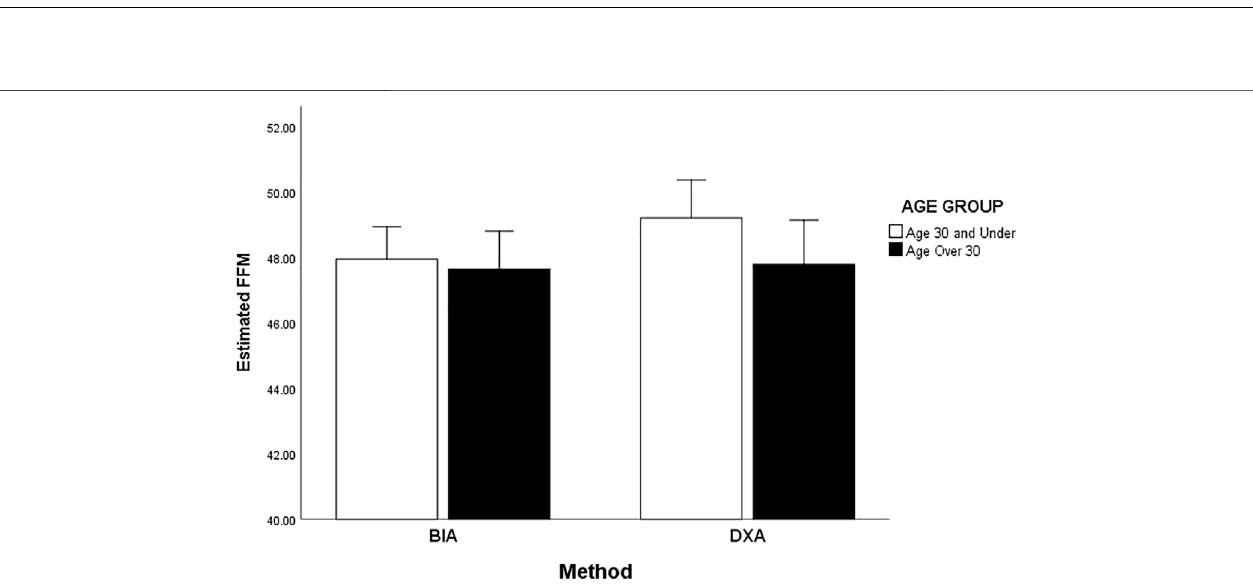
FIGURE 6 | Interaction effect of FFM by age and method BIA and DXA for women ( ≤ 30 and > 30).